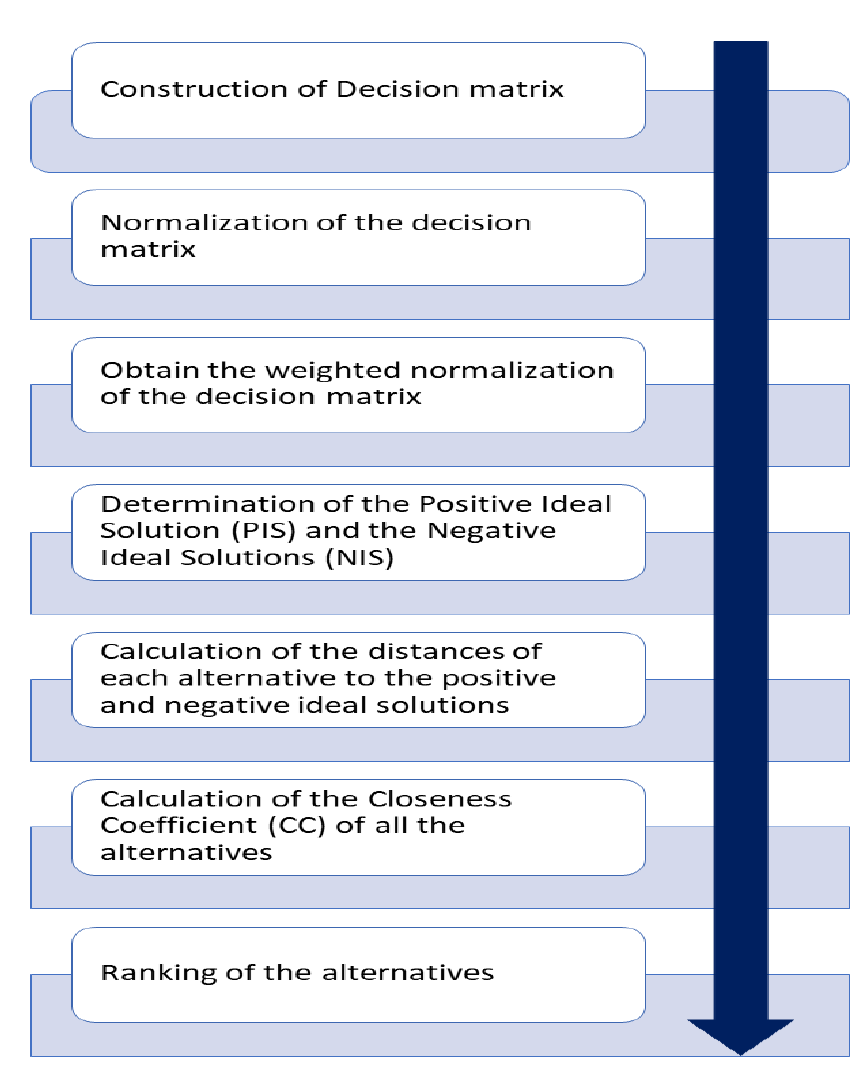
Figure 1. The main implementation steps for